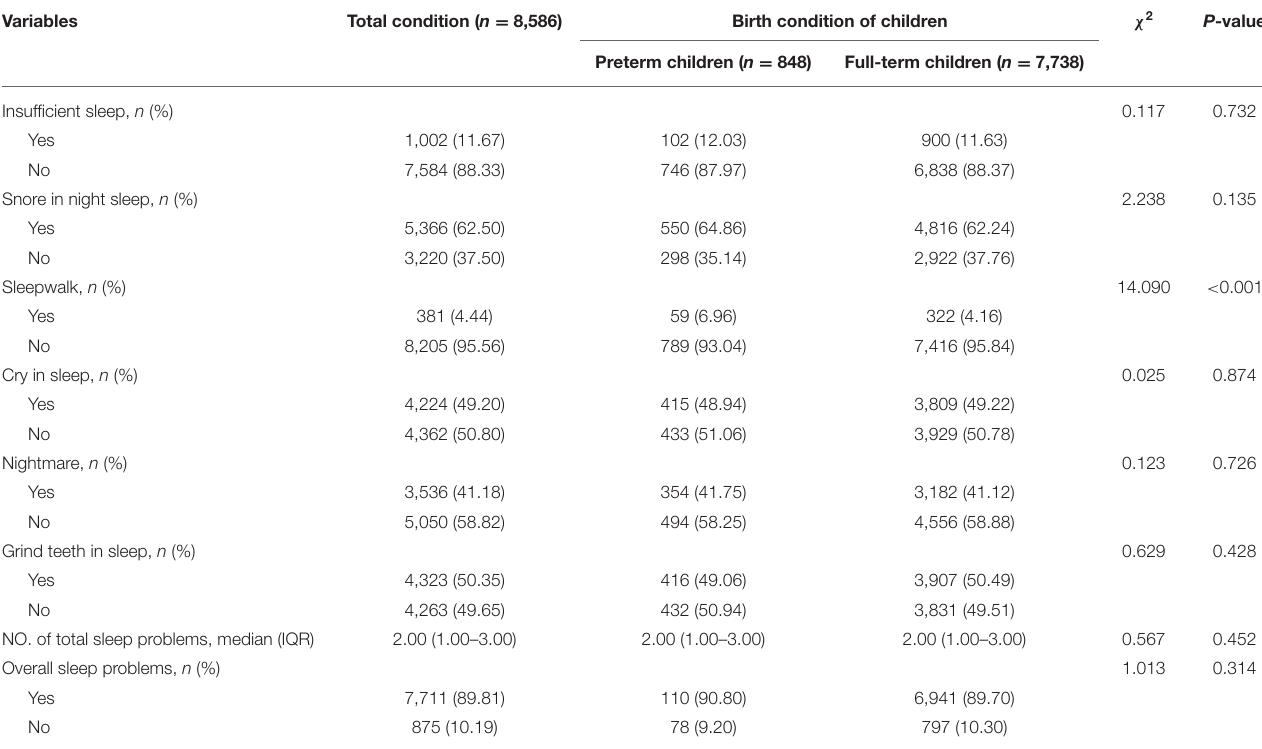
TABLE 2 | The sleep problems of kindergarten children aged 3–6 years in a rural area of Shanghai, China.